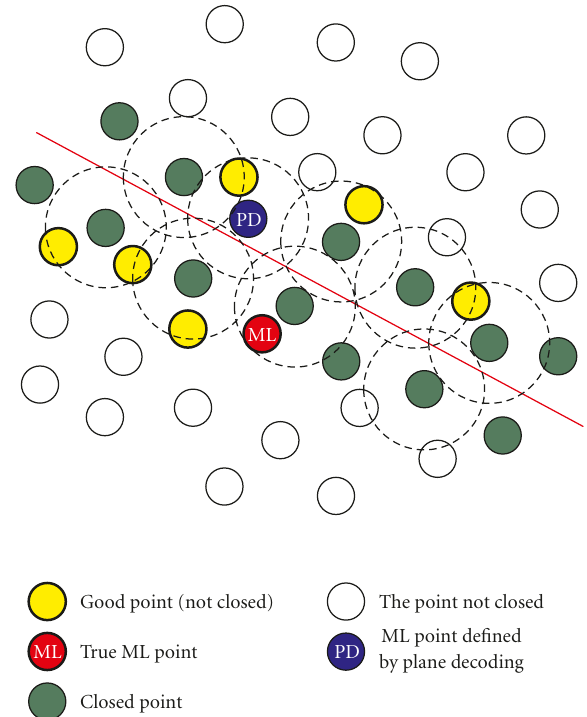
Figure 3: A diagram illustrating the good points obtained by in- cluding the neighboring points of some closed